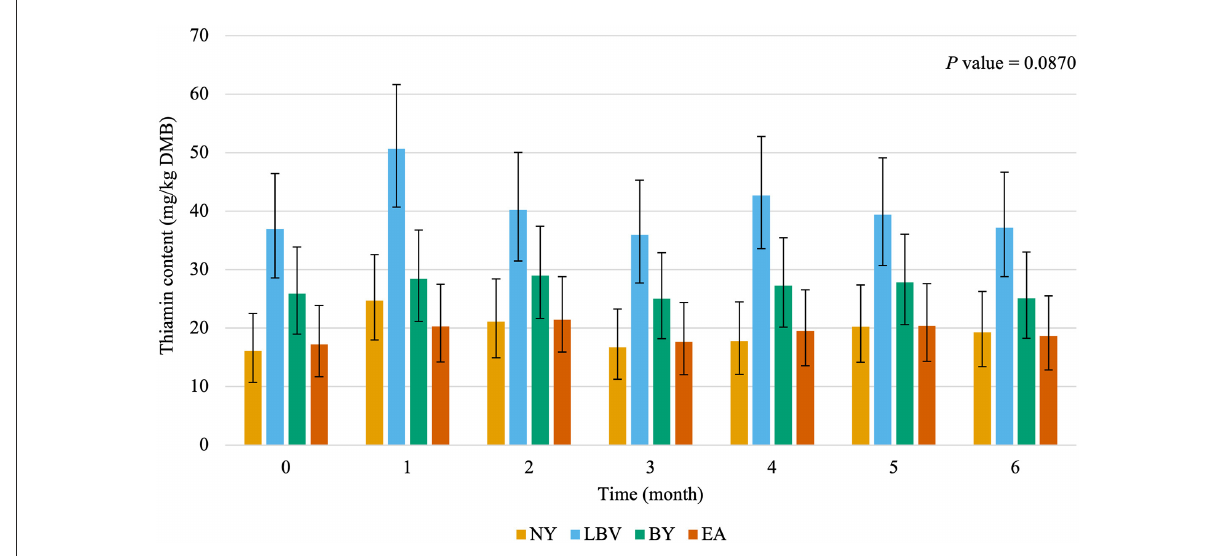
FIGURE6 Interaction of yeast inclusion 1 and time on dry matter basis (DMB) thiamin content (average with 95% confidence interval) of canned cat food stored in a commercial warehouse for 6 months. 1 NY, no yeast; LBV, Lalmin B-complex Vitamins; BY, spray dried brewer’s yeast #1064B; EA,